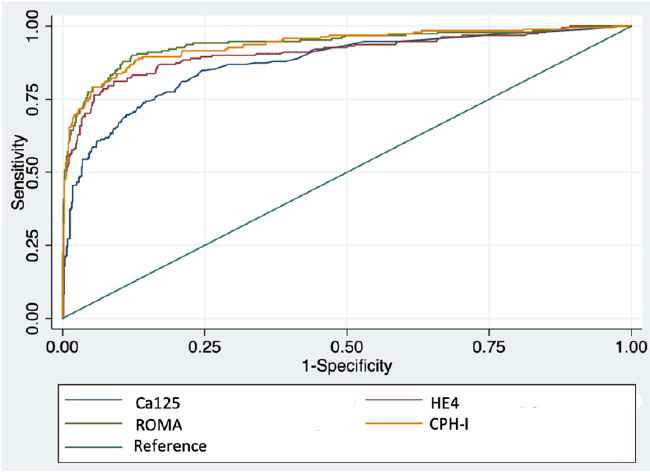
Figure 1. ROC curve of Ca125, He4, ROMA and CPH for diagnosis of EOC or MCO.